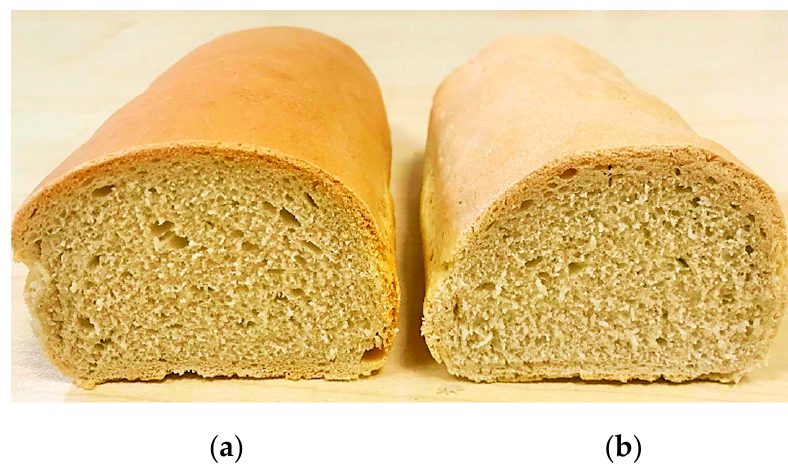
Figure 6. The bread samples obtained: ( a ) optimized bread sample, ( b ) control bread sample. From the color point of view, it may be seen that the optimized sample presents lower lightness ( L* value) and higher greenness ( a* value) and yellowness ( b* value) than the control sample. This